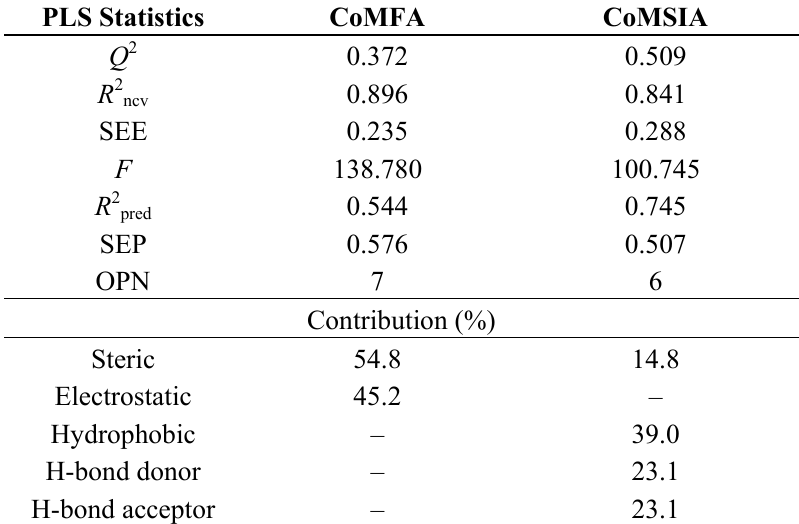
Table 1. Summary of comparative molecular field analysis (CoMFA) and comparative molecular similarity index analysis (CoMSIA)